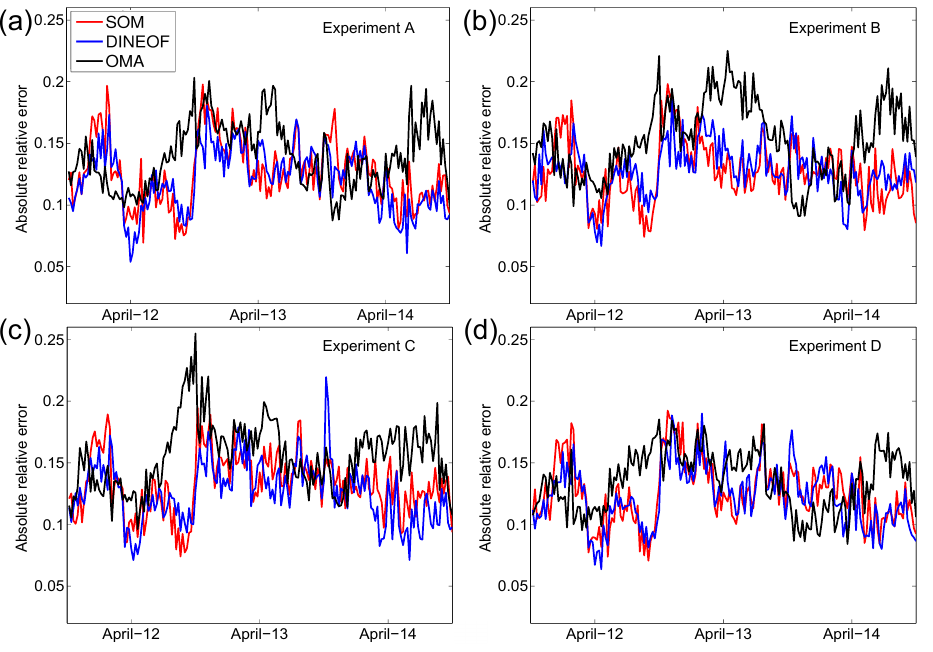
Figure 14. Time series of the spatial average of the pixel-by-pixel absolute relative error of the RT computed with the reconstructed velocities with respect to the REF-RT.